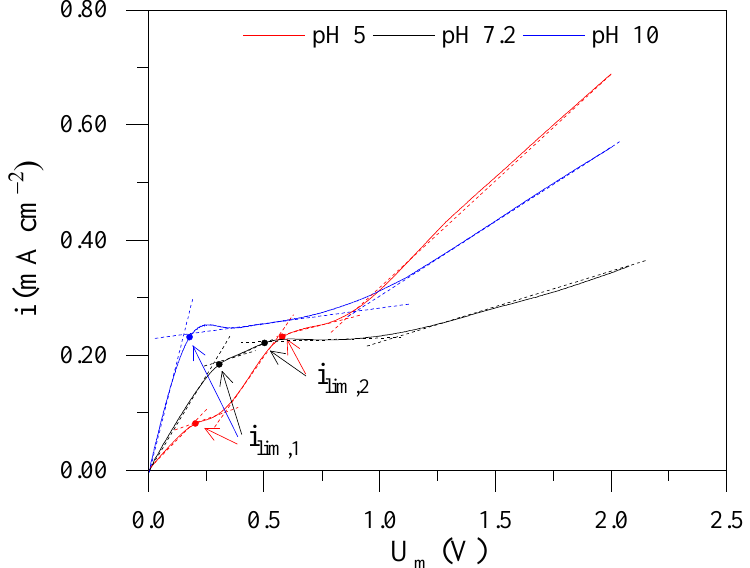
Figure 2. Polarization curves for the IONSEP-HC-A membrane in contact with a solution with 0.001 M of H x PO 43 − x at pH 5 (red line), 7.2 (black line), and 10 (blue line). Dotted lines represent the delimitation of polarization curve regions.